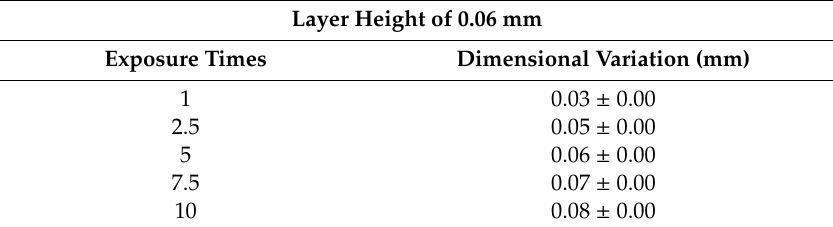
Table 4. Dimensional variation for each exposure time and layer height of 0.06 mm.